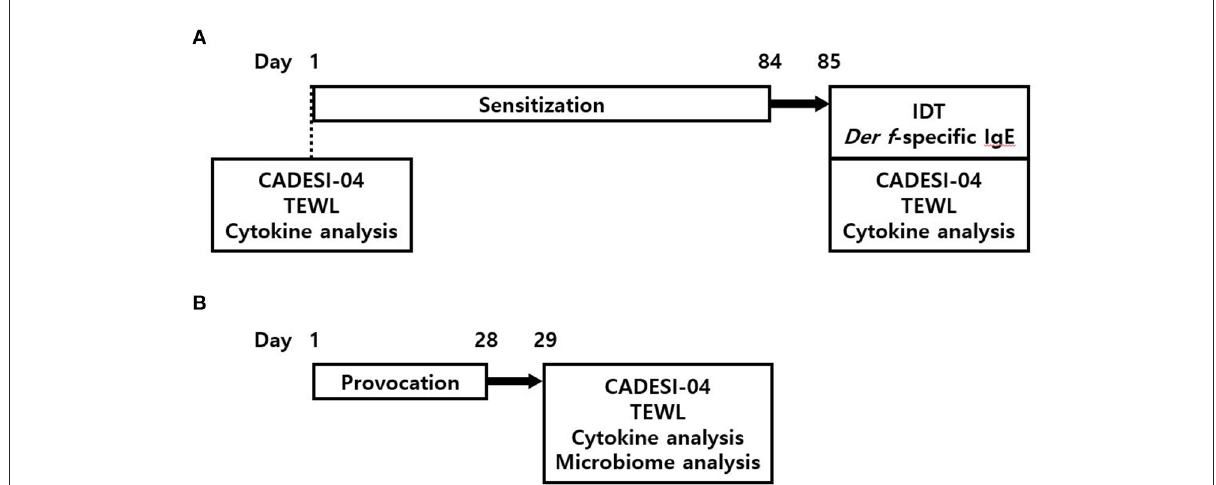
FIGURE1 An outline of the study. (A) In phase 1, six dogs were sensitized with Der f for 12 weeks; then, the IDT and Der-f specific IgE assay were performed as a means of verification of sensitization. (B) Phase 2 began three days after completion of phase I. Der f challenges for 4 weeks were conducted as part of provocation. An exposure to Der f was repeated twice a week at three-day and four-day intervals alternately, during both phase 1 and 2. Clinical scoring including CADESI-04 and TEWL, and serum cytokine analysis was performed at pre-sensitization, after-sensitization, and after-provocation. The skin microbiome analysis was also conducted after-provocation. Der f , Dermatophagoides farinae ; CADESI, canine atopic dermatitis extent and severity index; TEWL, transepidermal water loss.